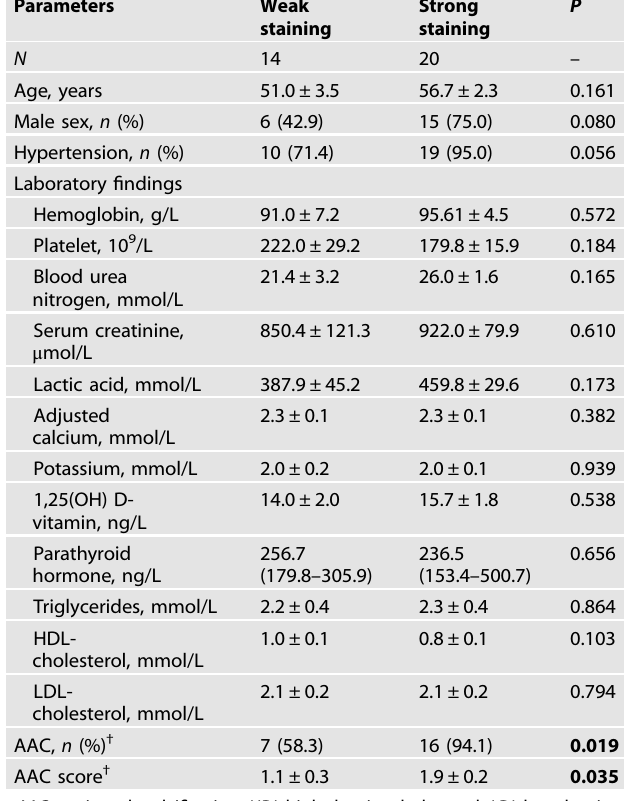
Table 1. Comparison of baseline demographics and clinical characteristics of CKD patients with weak and strong COX15